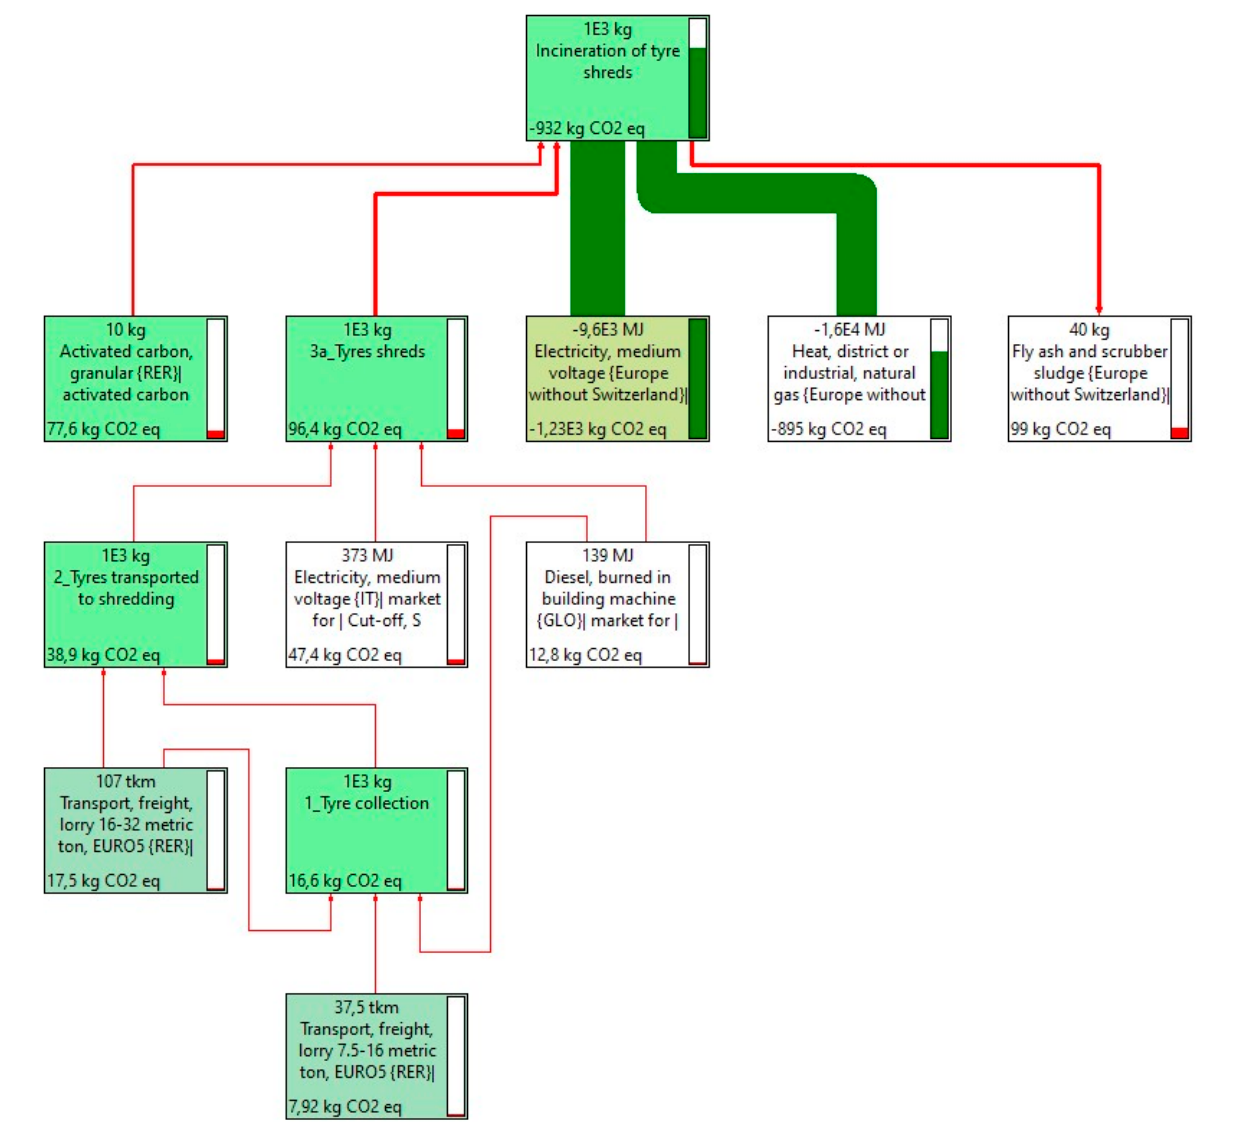
Figure 4. Flow chart with impacts and benefits of the incineration scenario.